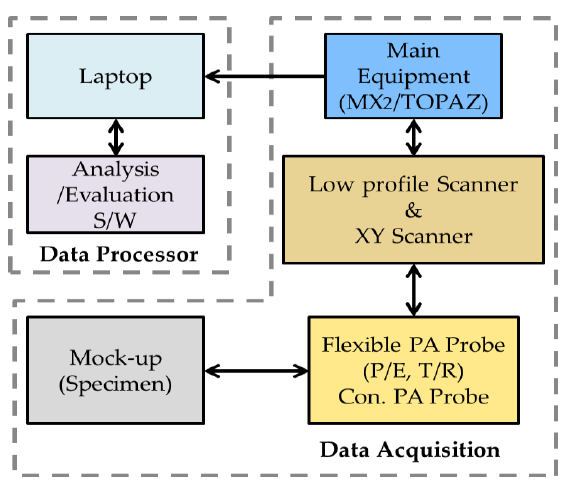
Figure 14. Schematic diagram of experimental setup.